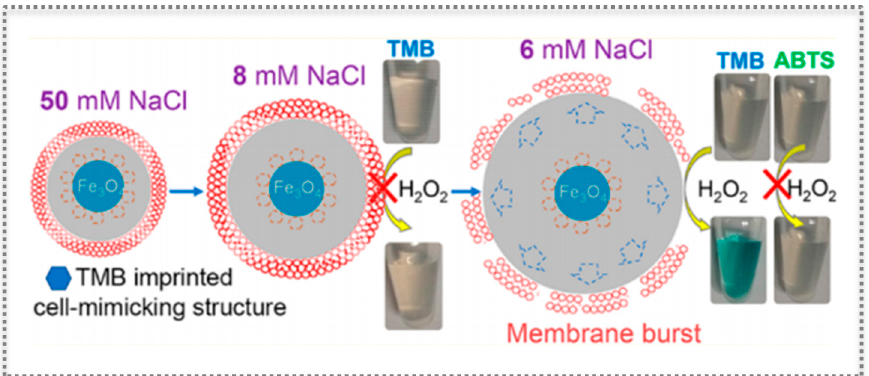
Figure 11. Cell-mimicking protocell of three components with a peroxidase-like iron oxide core as nucleus, a molecularly imprinted hydrogel shell as cytoplasm, and a lipid bilayer for biomedical applications. (Reproduced with permission [97], Copyright 2017, American Chemical Society).